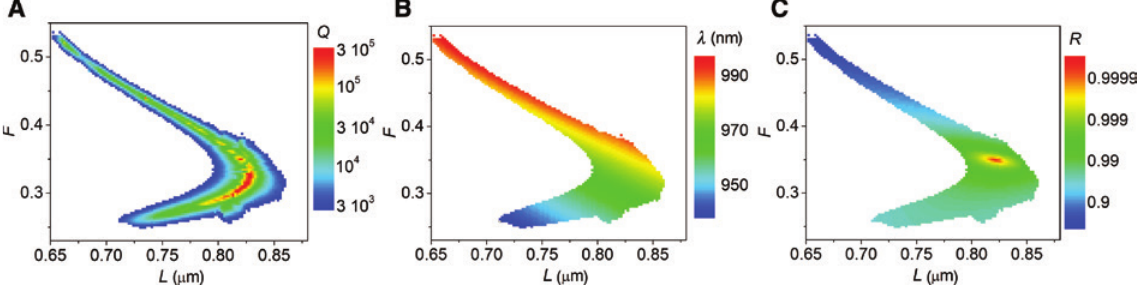
Figure 8: (A) Q -factor and (B) resonant wavelength of M-M microcavity and (C) power reflectance of MHCG mirror. (A) Q -factor, (B) resonant wavelength ( λ ), and (C) power reflectance ( R domain of geometrical parameters L and F of the MHCG when h